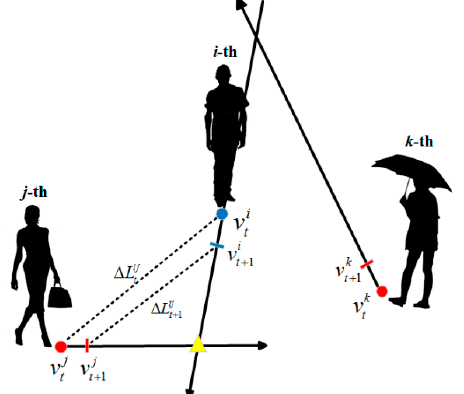
Figure 5. An illustration of the directional graph, where the lines represent the direction of motion, circles and squares indicate the position of time t and t + 1, dashed lines indicate the spatial distance between pedestrians, and triangles indicate the existence of collision possibilities.